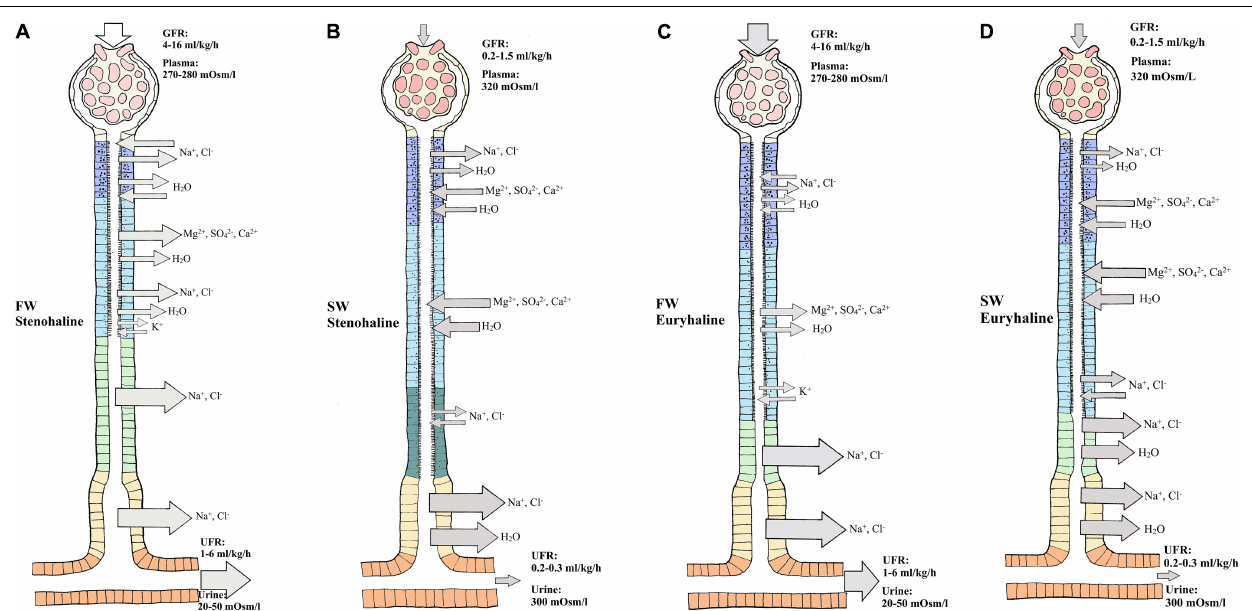
FIGURE 2 | Overview of water and ion movement in freshwater teleost nephron (FW) and seawater teleost nephron (SW). FW (A,C): In a FW fish kidney, most ions are reabsorbed, and water follows by diffusion. Therefore, impermeable features of the distal and collecting duct can reabsorb Na + and Cl - with minimal accompanying osmotic movement. The glomerulus filters (GFR) roughly 4–16 milliliter/kilogram/hours (ml/kg/h) of plasma (270–280 mOsm/L) while producing (UFR) roughly 1-6 ml/kg/h of dilute urine (20–50 mOsm/L). SW (B,D): In a SW fish kidney, most divalent ions are secreted and water follows by osmosis. To counter water loss and dehydration in SW fish, distal and collecting tubule must be more permeable enabling effective Na + and Cl - reabsorption while water can follow by osmosis. The glomerulus filters (GFR) roughly 0.2–1.5 ml/kg/h of plasma (320 mOsm/L) while producing (UFR) roughly 0.2–0.3 ml/kg/h of concentrated urine (300 mOsm/L) rich in SO 42 - and Mg 2 + . Different sections of the nephron are displayed as follows: Glomerulus (G), Neck segment (NS), Proximal tubule I (PTI), Proximal tubule II (PTII), Distal tubule (DT), Colleting tubule (CT) and collecting duct (CD). Keep in mind that the nephron in euryhaline teleost in FW and SW environments usually has a distal segment (model C and D) commonly found in stenohaline FW teleosts (Model A) while stenohaline SW teleosts (model B) possess a third proximal segment. Transport in the collecting duct are not indicated here but are known to have similar roles as in the collecting tubule. Models modified from the paper of Hickman and Trump (1969) and Marshall and Grosell